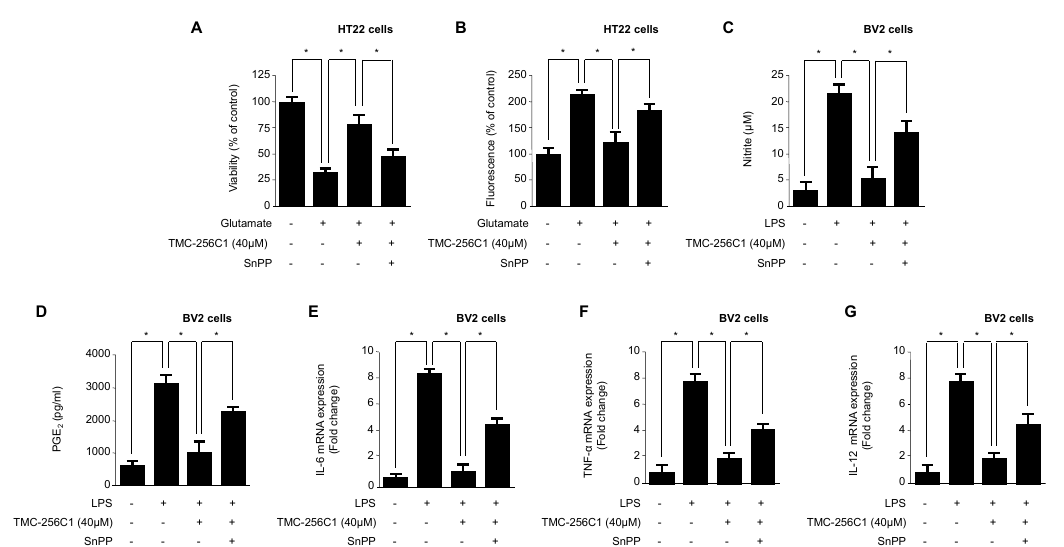
Figure 7. Effects of tin protoporphyrin (SnPP) on glutamate-induced oxidative neurotoxicity ( A ) and reactive oxygen species generation ( B ) in HT22 cells, and inhibition of nitrate ( C ); PGE 2 ( D ); IL-6 ( E ); and TNF- α ( F ) IL-12 ( G ) production by TMC-256C1 pre-treatment of lipopolysaccharide (LPS)-stimulated BV2 cells. HT22 cells were pre-treated with TMC-256C1 in the presence or absence of SnPP (50 μ M) and then incubated for 12 h with glutamate (5 mM) ( A ). Exposure of HT22 cells to 5 mM glutamate for 12 h in the presence or absence of SnPP (50 μ M) increased reactive oxygen species production ( B ). BV2 cells were pre-treated for 3 h with TMC-256C1 (40 μ M) in the presence or absence of SnPP (50 μ M) and stimulated for 24 h with LPS (1 μ g/mL) ( C – G ). HT22 cells and BV2 microglia were pretreated with SnPP for 3 h in this experiment. Data are presented as the mean value of three experiments ± SD. * p < 0.05 (Newman-Keuls post hoc test).